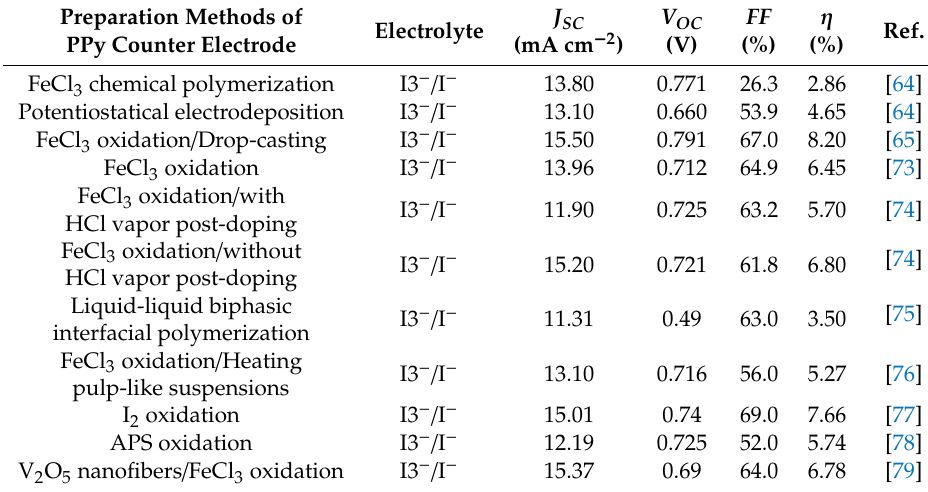
Table 1. Photovoltaic performances parameters of DSSCs based on the PPy counter